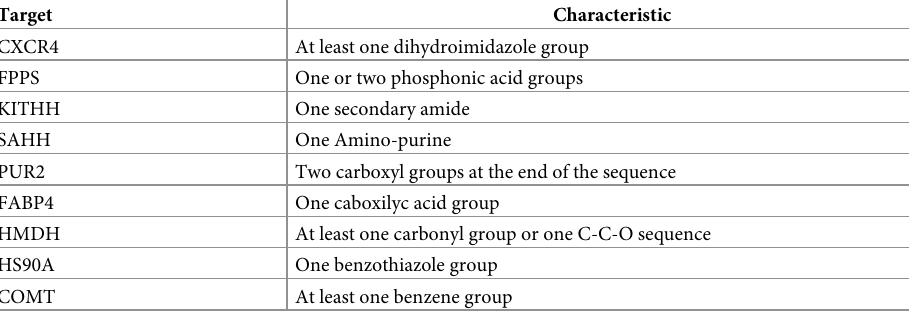
Table 2. Chemical characteristics of the best performing classes with